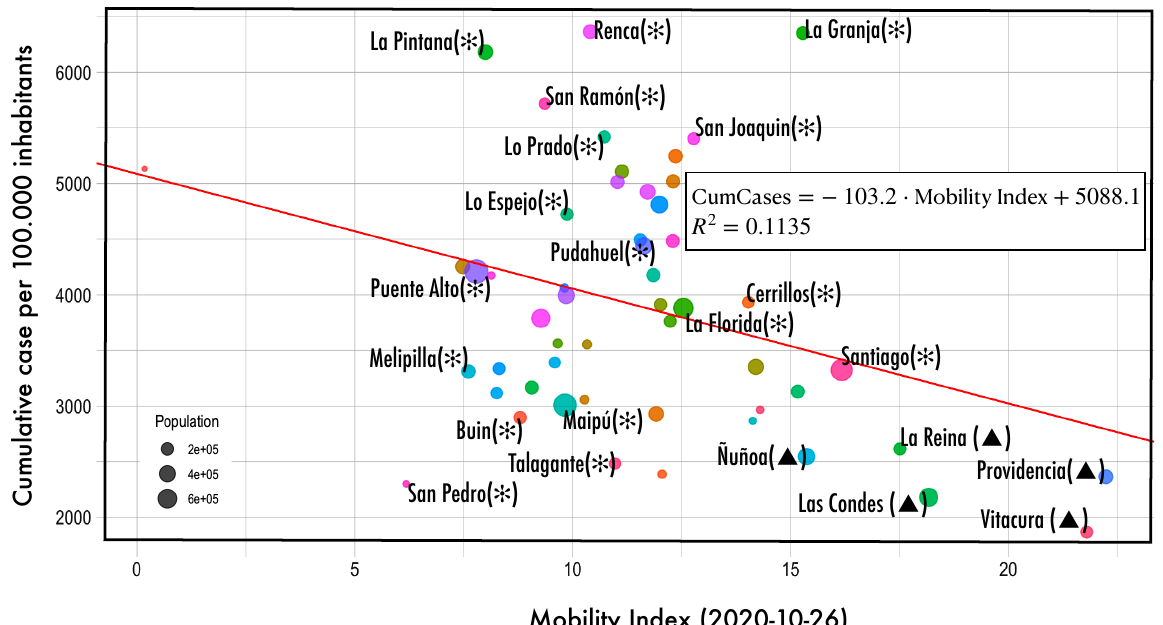
Figure 12. The mobility index vs. the cumulative number of cases per 100.000 inhabitants after relaxing the confine- ment